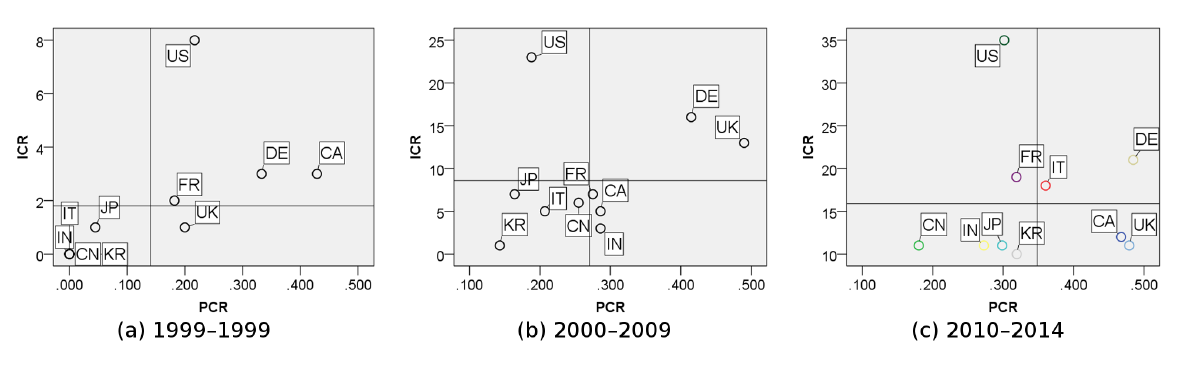
Figure 3: Scatter plot of international collaboration index (ICI) for top 10 countries in (a) 1990–1999; (b) 2000–2009; (c) 2010–2014. The guides indi- cate the average value of these top 10 countries.